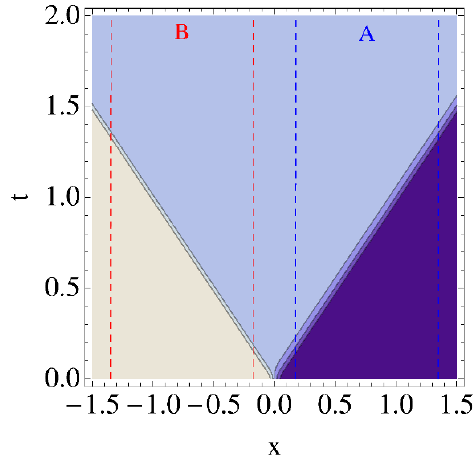
Figure 4 . Contour plot of energy density h T tt ( t; x ) i with the model in d = 2, see section 2. Dashed lines show the time evolution of the endpoints of the intervals A and B , in the positive and negative semiplane respectively. We consider the intervals x A 2 [0 : 175 ; 1 : 35] (blue) and x B 2 [ (cid:0) 1 : 35 ; (cid:0) 0 : 175] (red), temperatures T L = 0 : 2, T R = 0 : 195 and (cid:11) = 25 (in equation (2.9)), in units in which L = 1.